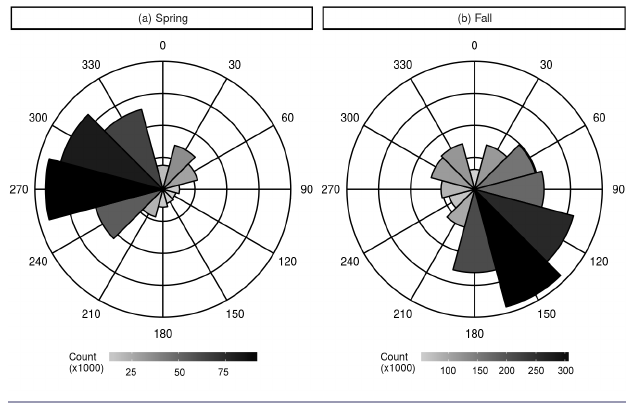
Fig. 2 . The averaged bearings of spring and fall migrants across